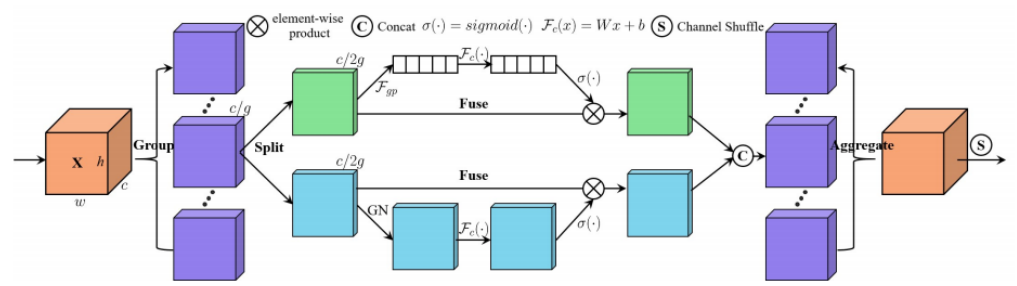
Figure 9. Overall structure of shuffle attention.